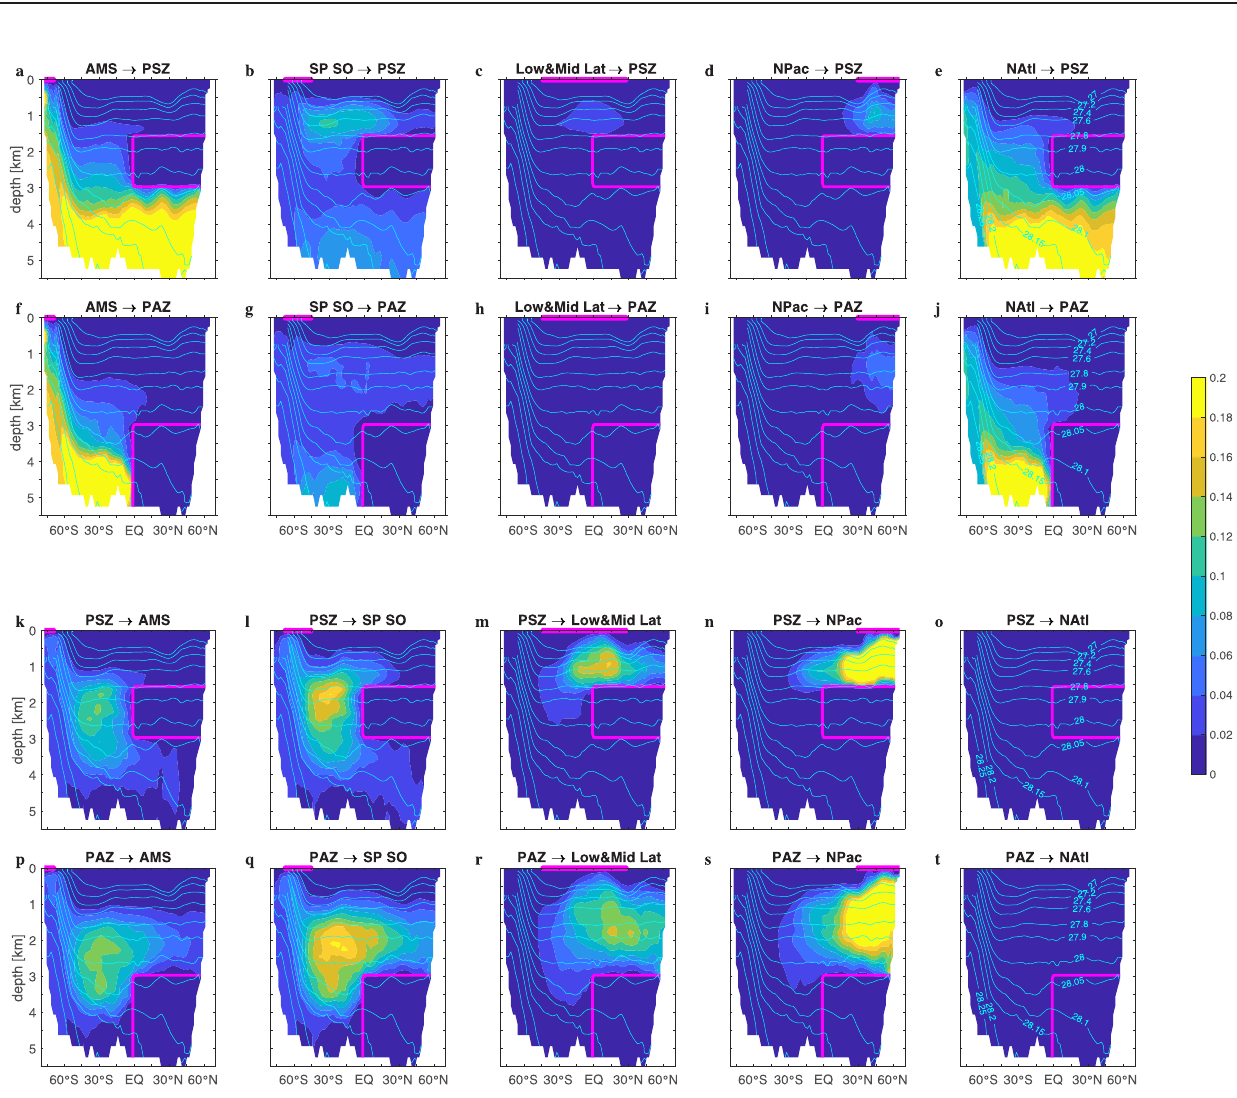
Fig. 5 Paci fi c zonal mean path densities. Paci fi c zonal averages of the surface-to-interior path density ( a – j ) and of the interior-to-surface path density ( k – t ). (The path density is the dimensionless local fraction of water in origin-to-destination transit – see Methods.) Surface origin or destination regions as indicated in the titles and de fi ned in Fig. 4a: Antarctic marginal seas (AMS), subpolar Southern Ocean (SP SO), low and mid latitudes (Low&Mid Lat), the northern Paci fi c (NPac), and the northern Atlantic (NAtl). The magenta outlines indicate the Paci fi c Shadow Zone (PSZ) or the Paci fi c Abyssal Zone (PAZ) and the part of the surface regions within the Paci fi c, while the cyan contours are Paci fi c zonal mean neutral density ( − 1000) in units of kg m − 3 . A generic feature of the A → B path density in the presence of diffusion is that is goes to zero close to A and close to B, where most water undergoes either A → A or B → B return trips 72